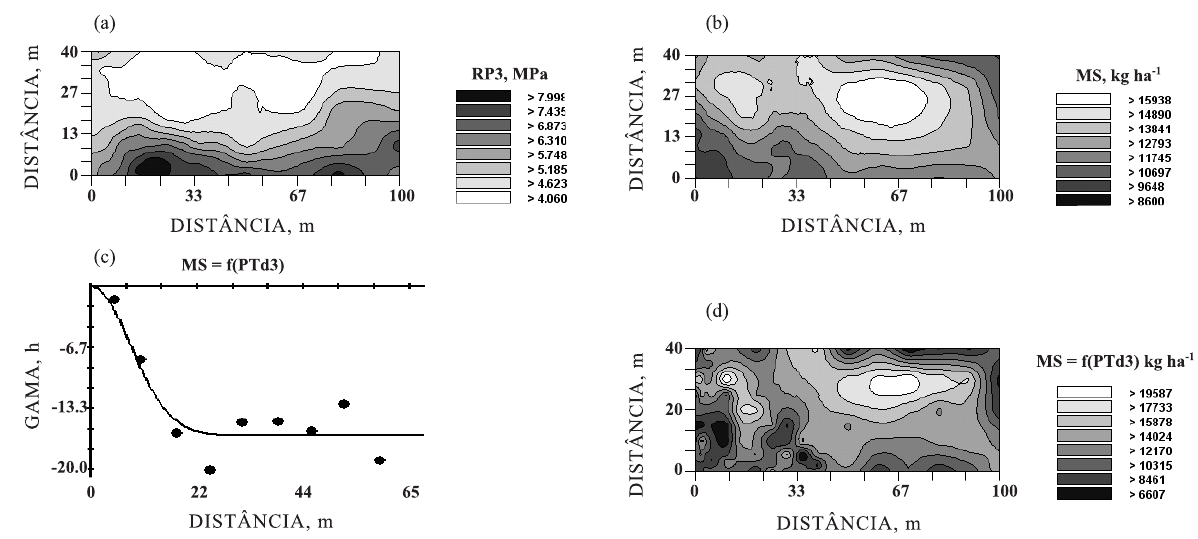
Figura 1. Mapas de krigagem do atributo RP3 do solo (a) e MS de Brachiaria brizantha (b) e semivariograma cruzado (c) e mapas de cokrigagem da produtividade de matéria seca (MS) de Brachiaria brizantha em função da porosidade total (PT3) (d) num Latossolo Vermelho distroférrico de Selvíria